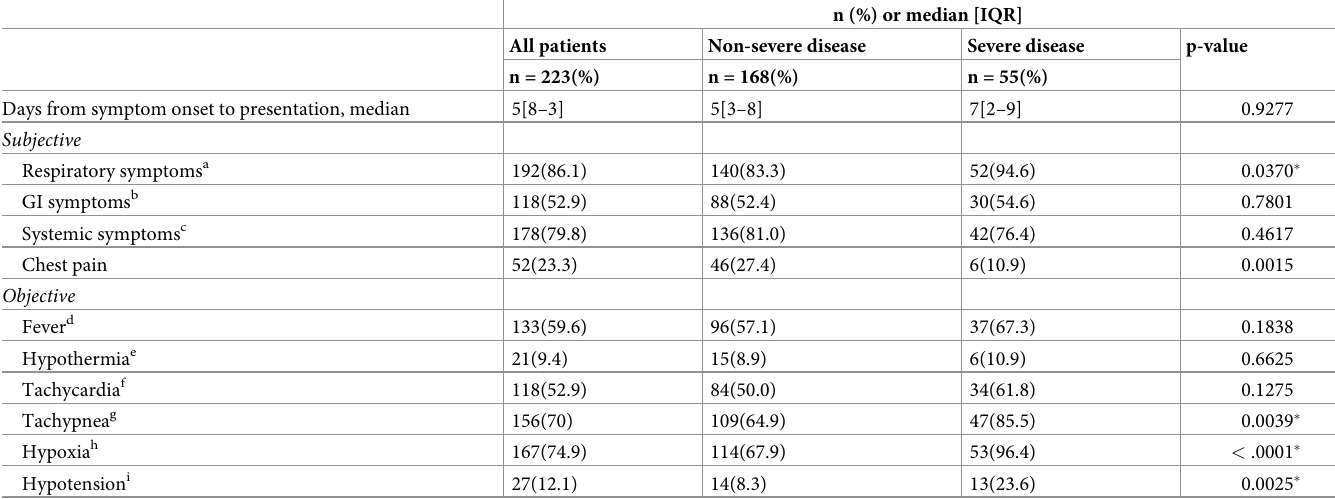
Table 5. Presenting symptoms and signs during the first 24 hours of